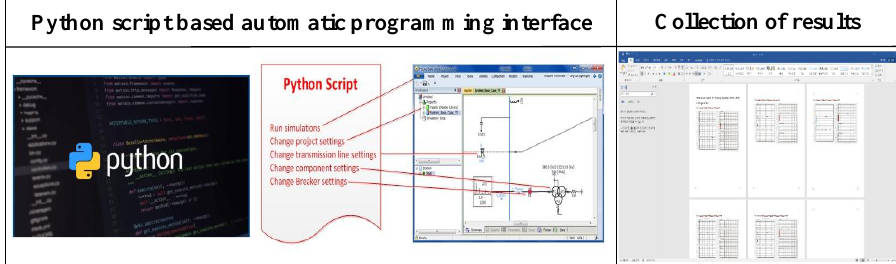
Figure 6. Python script-based detailed PSCAD/EMTDC iterative study method